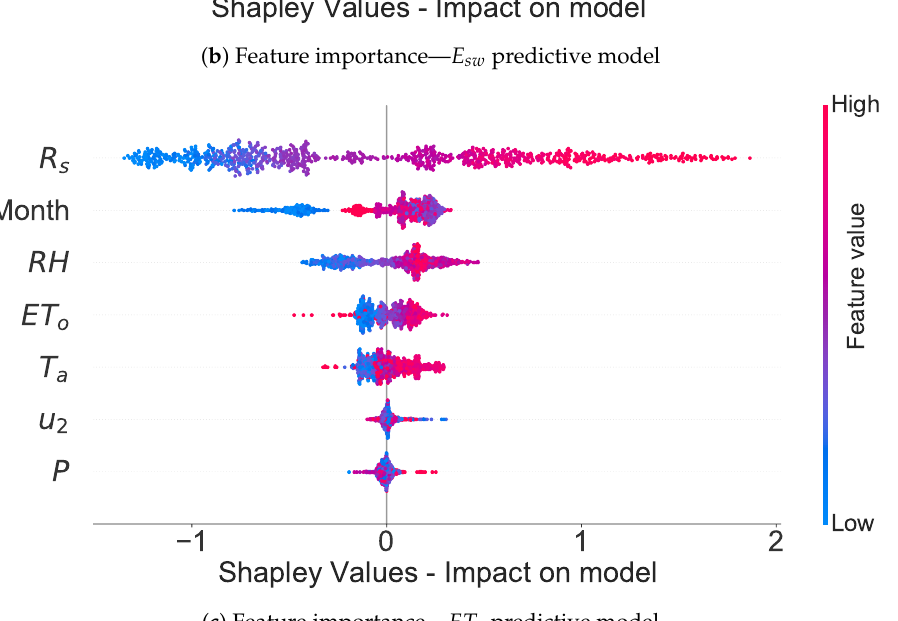
Figure 5. The order of importance of hydroclimate variables on the ET o , E sw , and ET a